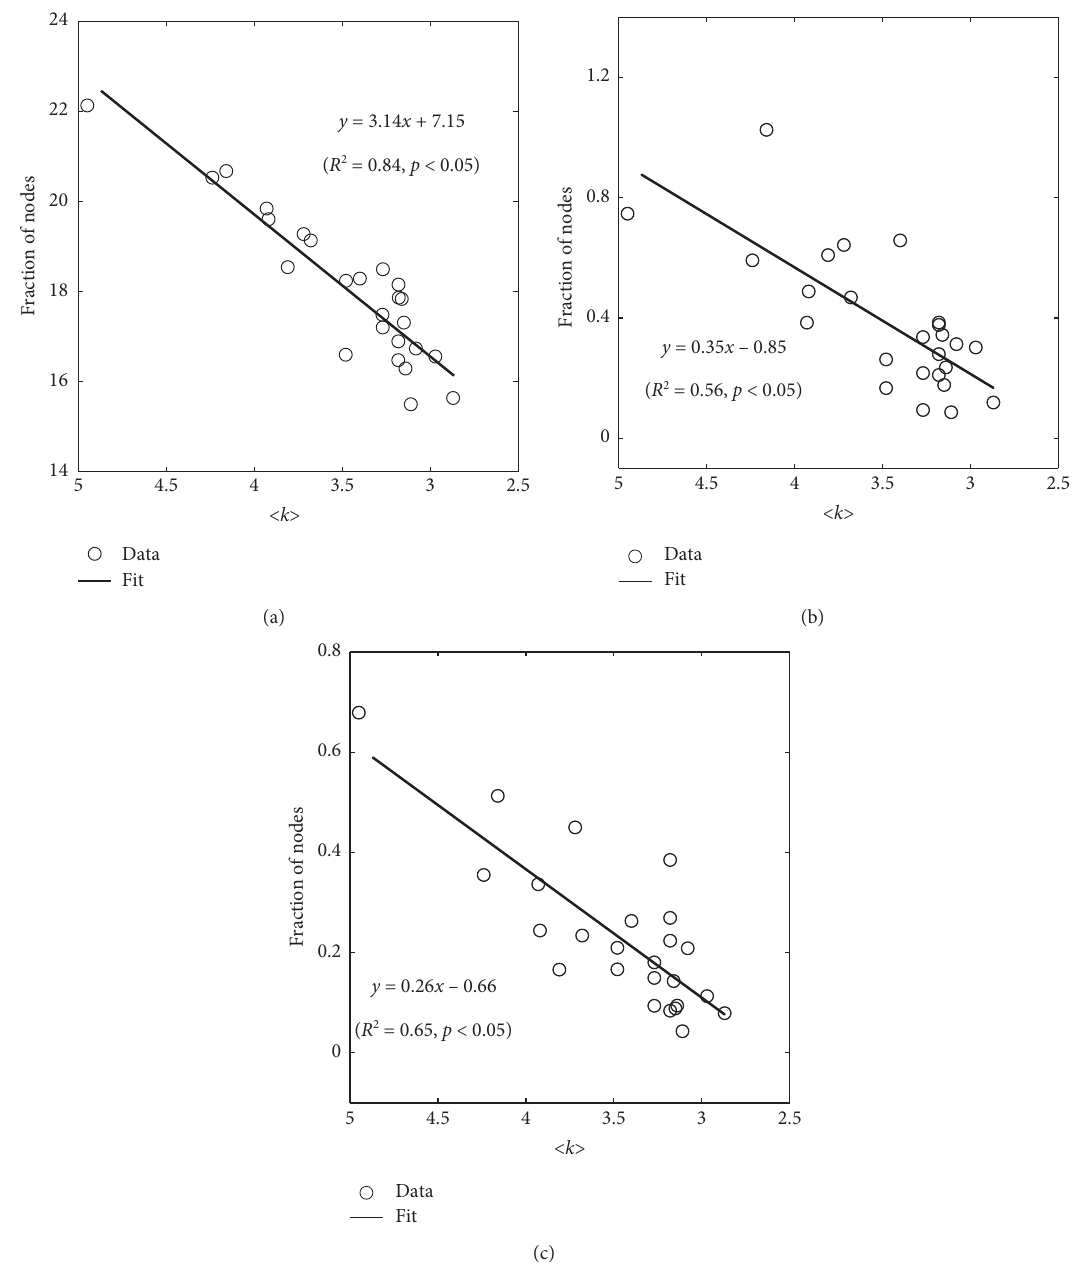
Figure 6: Fraction of nodes required to reduce 50% of initial efficiency over < k > by (a) random removal, (b) degree-based attack, and (c) betweenness-based